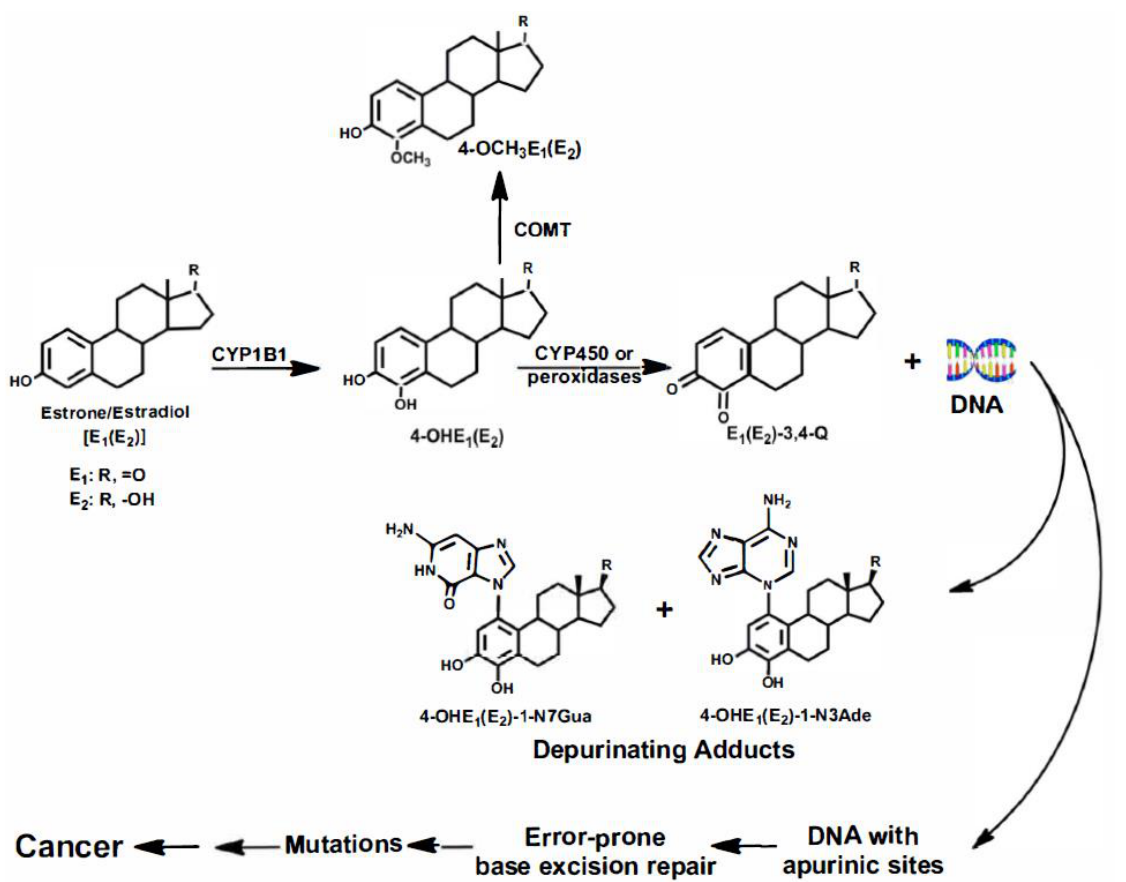
Figure 1. Pathway of cancer initiation by estrogens.